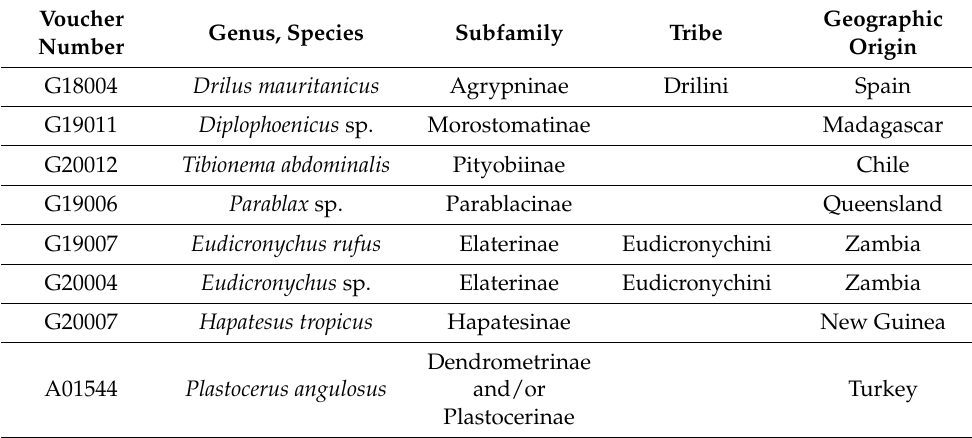
Table 1. The sequenced samples of Elateridae included in this